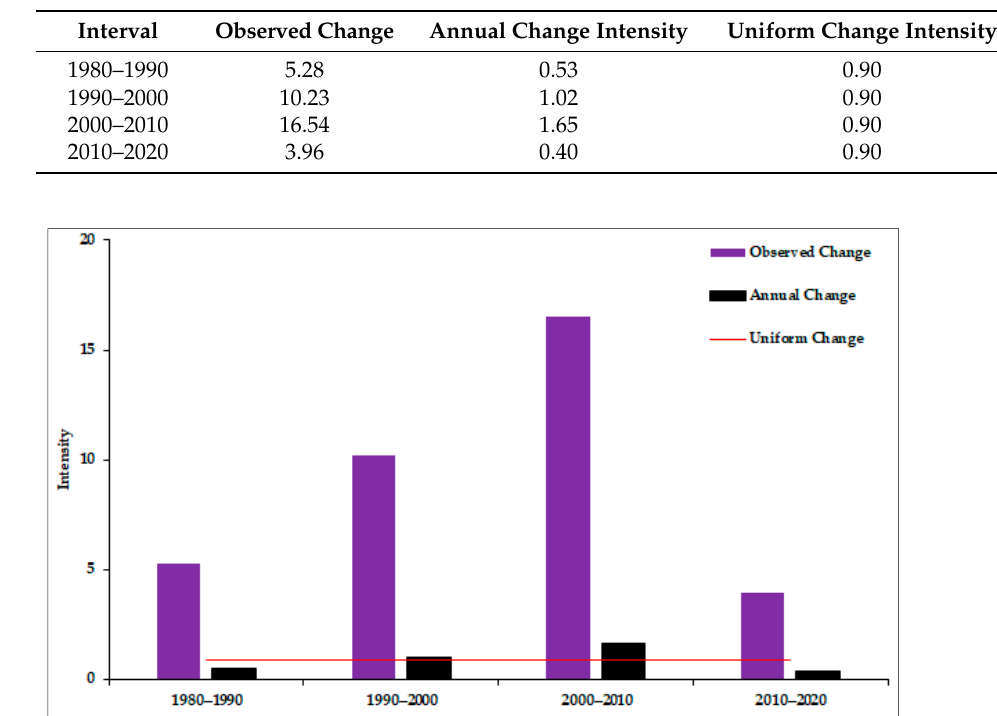
Figure 10. Interval-level change intensity.